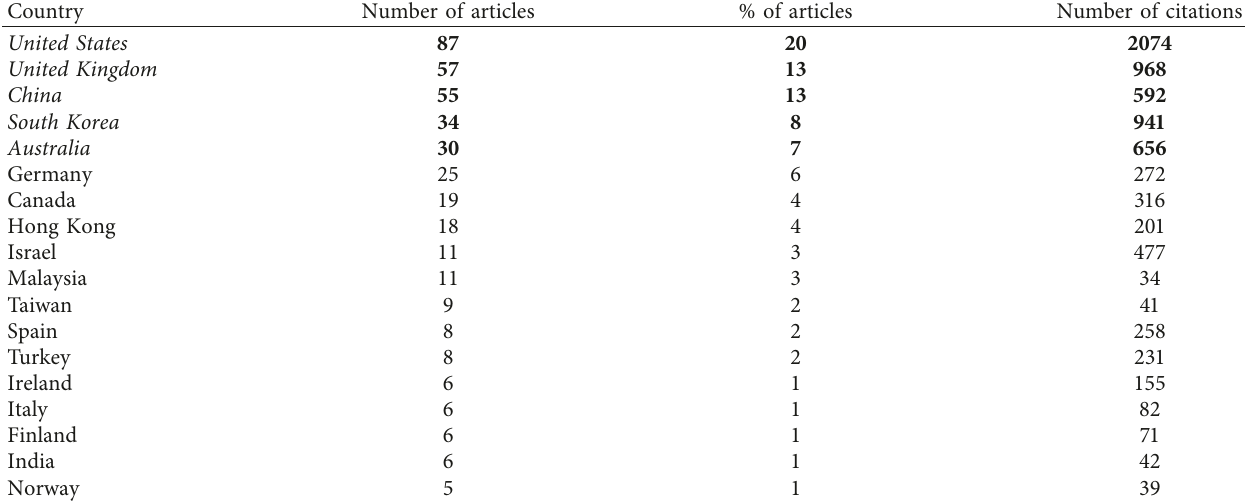
Table 3: The most active countries, where the number of articles exceeds or equals 5 (Scopus, December 2018).